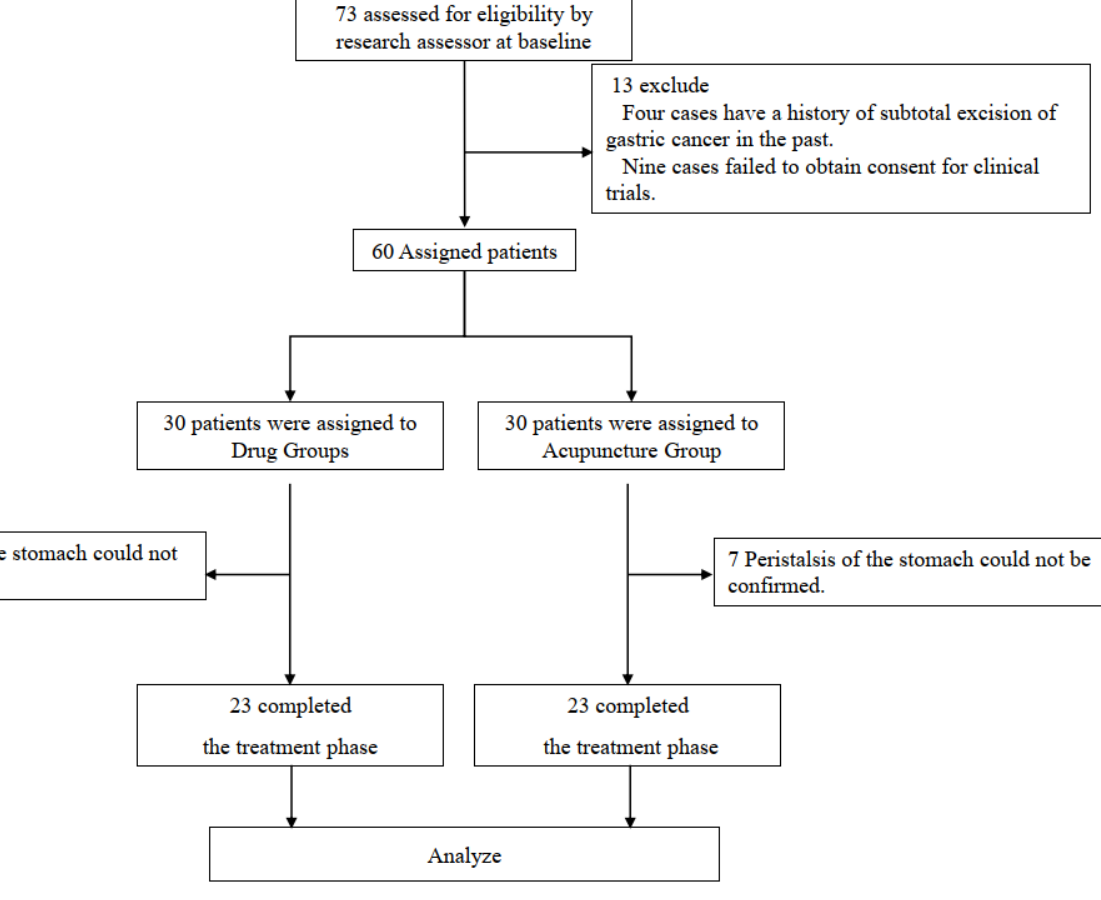
Figure 2. Flow chart of the study participants.